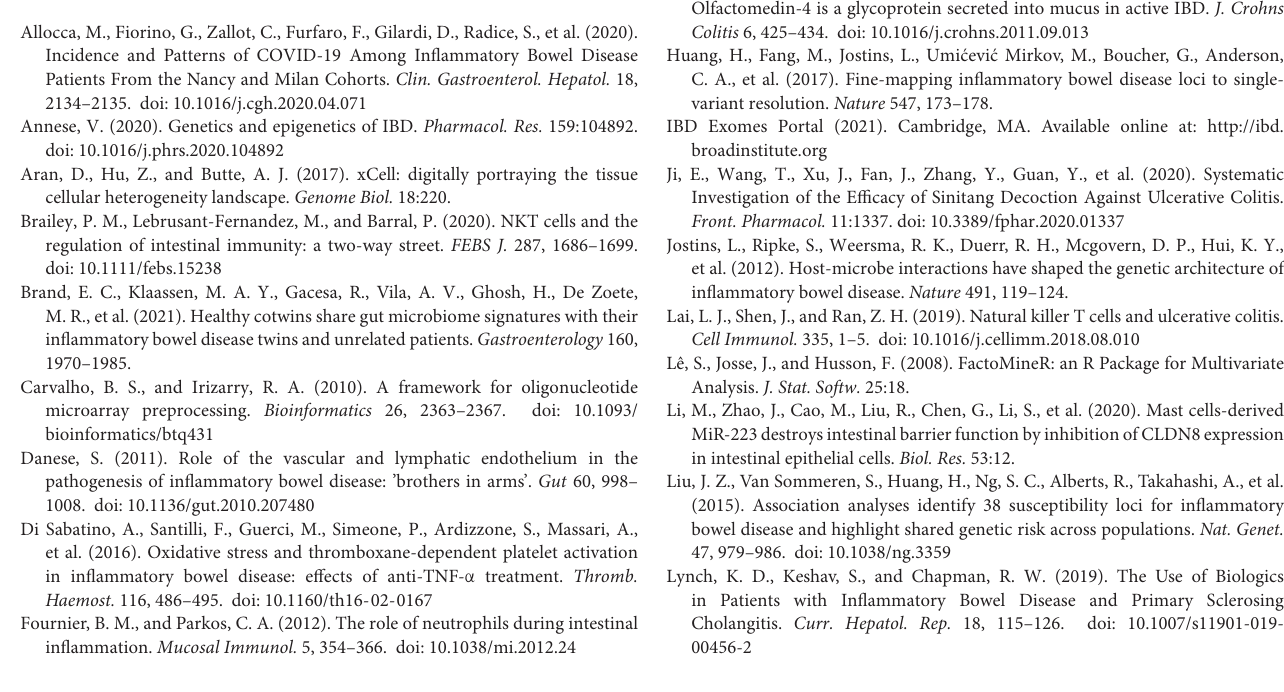
Supplementary Figure 4 | Venn diagram of the candidate disease-causative genes with evidence from GWAS-FineMapped, DiseaseNet and the DEGs. Supplementary Table 1 | The enriched human phenotypes and disorders related to the fine-mapped genes. Supplementary Table 2 | Differentially expressed genes identified in the discordant IBD twin pairs. The adjusted p -value was computed by Benjamini-Hochberg correction. Supplementary Table 3 | The intersection of the genes across FineMapped, DiseaseNet, and DEGs. Supplementary Table 4 | The non-silent variants of CYP2C18 that were enriched in